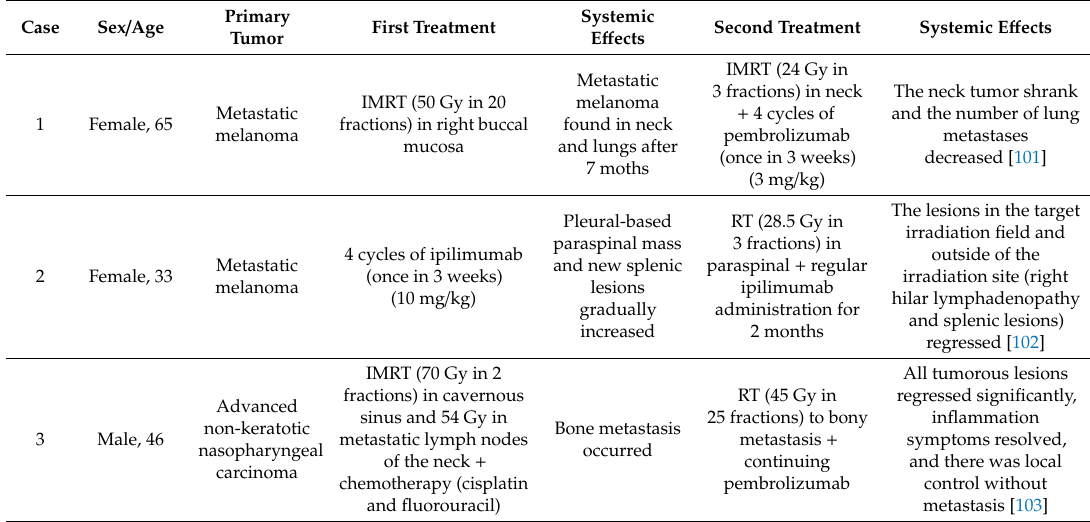
Table 2. Clinical cases and systemic e ff ect for combined RT with checkpoint